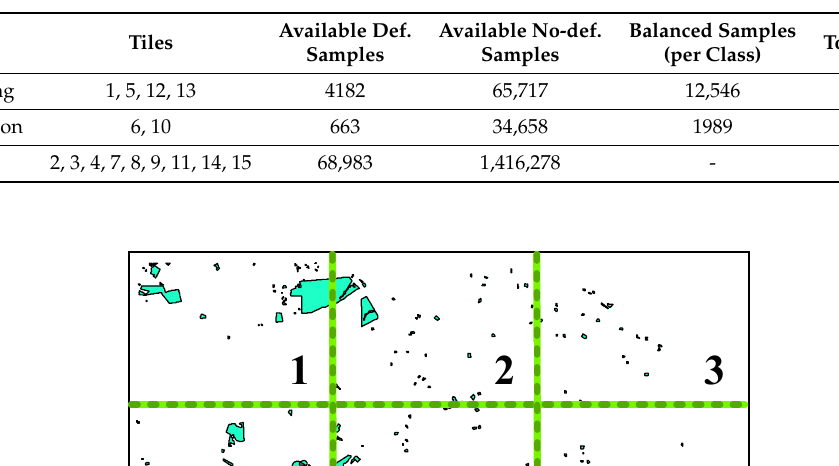
Table 2. Number of samples in the training, validation and test sets for Cerrado database.